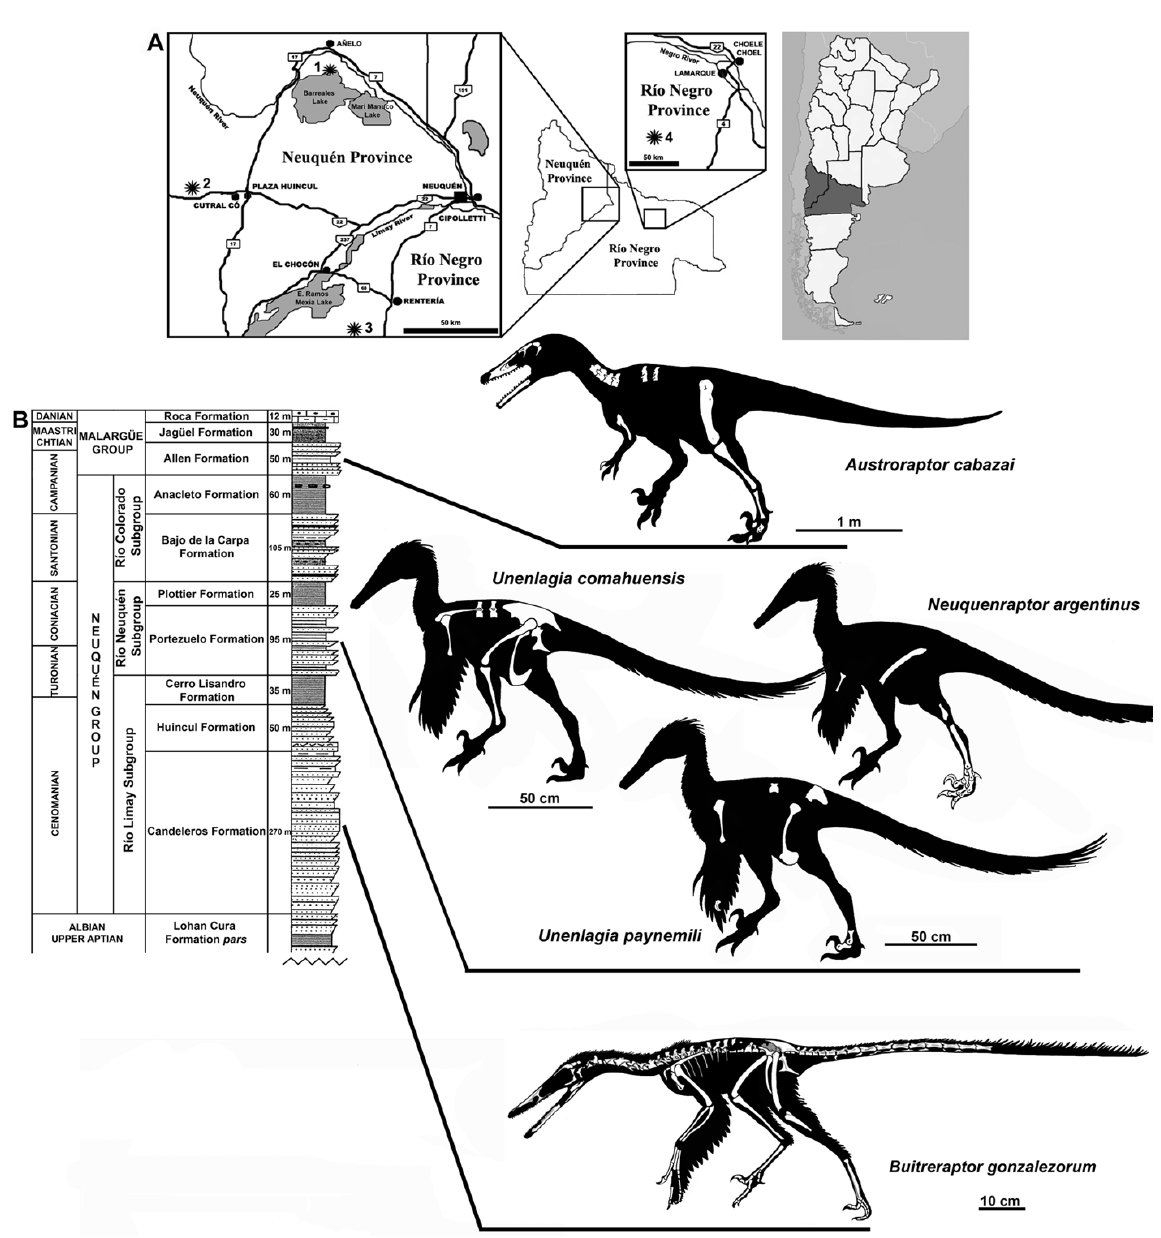
Fig. 1 – A : geographic provenance of the Patagonian dromaeosaurids taxa. The numbers in the maps correspond to the localities of provenance of each taxon. 1: Futalongko Site, Lago Barreales Paleontological Center, Neuquén Province: Unenlagia paynemili . 2: Sierra del Portezuelo, Neuquén Province: Unenlagia comahuensis and Neuquenraptor argentinus . 3: La Buitrera, Río Negro Province: Buitreraptor gonzalezorum . 4: Bajo de Santa Rosa, Río Negro Province: Austroraptor cabazai . B : stratigraphic provenance of Patagonian dromaeosaurid taxa. Each taxon is figured schematically through its body silhouette containing the preserved bones ( Buitreraptor modified from Jaime Headden